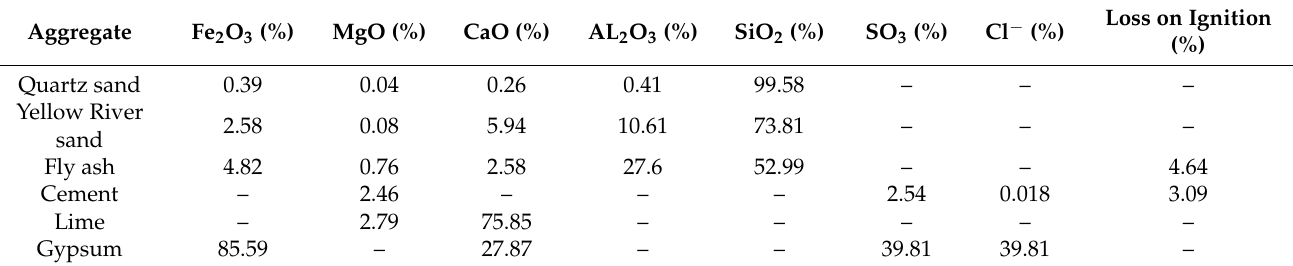
Table 1. Composition of autoclaved aerated concrete (AAC) and base